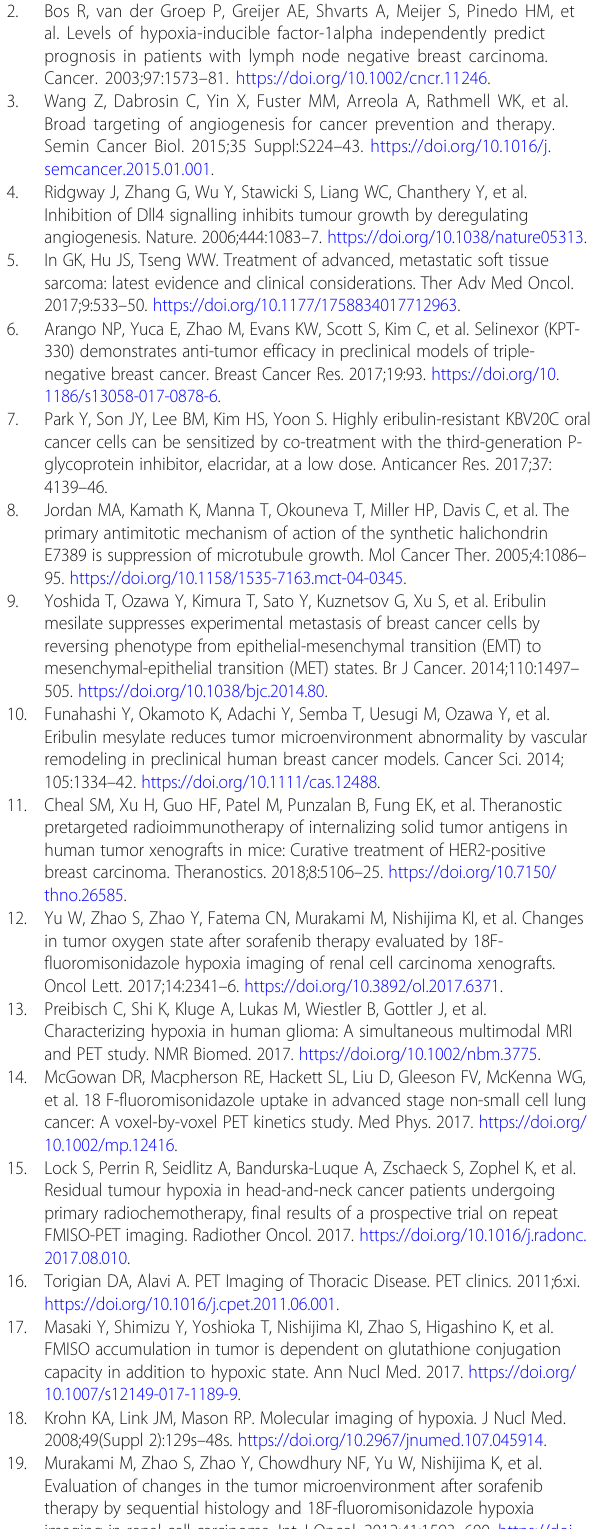
Abbreviations 18 F-FMISO: 18 F-Fluoromisonidazole; PET: Positron emission tomography;